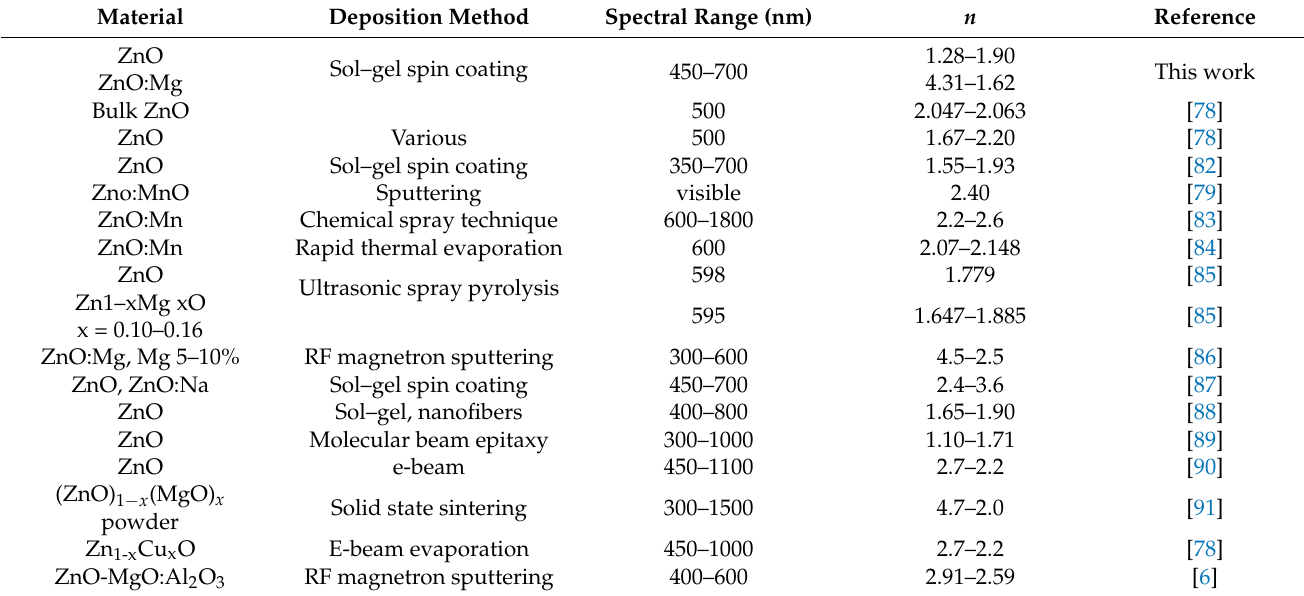
Table 1. Comparison of the refractive index n of ZnO-based materials, deposited by different